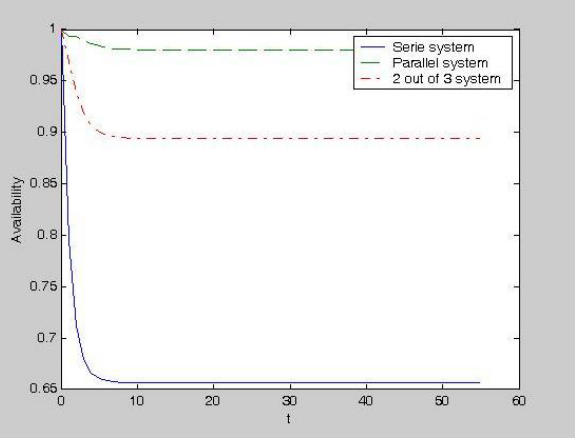
Figure 1. Comparison of the availability in series, parallel, and 2-out-of-3 systems. As expected, the availability is significantly higher when units are arranged in